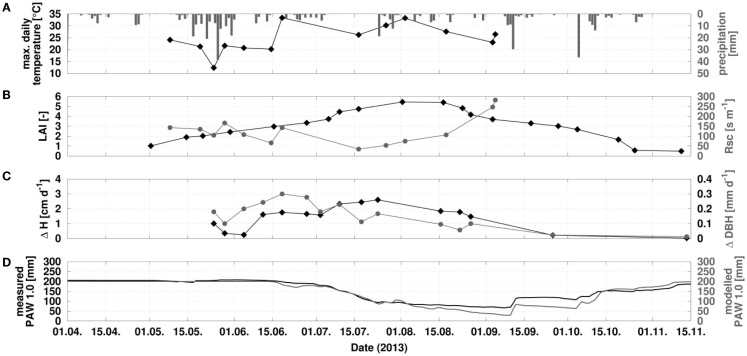
Time series of daily max. temperature, precipitation, leaf area index, stomatal resistance, growth parameters, and soil water changes of a poplar SCR in Reiffenhausen (Lower Saxony) in 2013. (A) Daily max. temperature and precipitation; (B) measured course of leaf area index and stomatal resistance; (C) measured growth rate of tree height (ΔH) and diameter at breast height (ΔDBH); (D) measured and modeled course of plant available water, calculated until 1 m soil depth (PAW1.0). Black drawings with diamonds belong to the right axis, gray ones with circles to left axis.